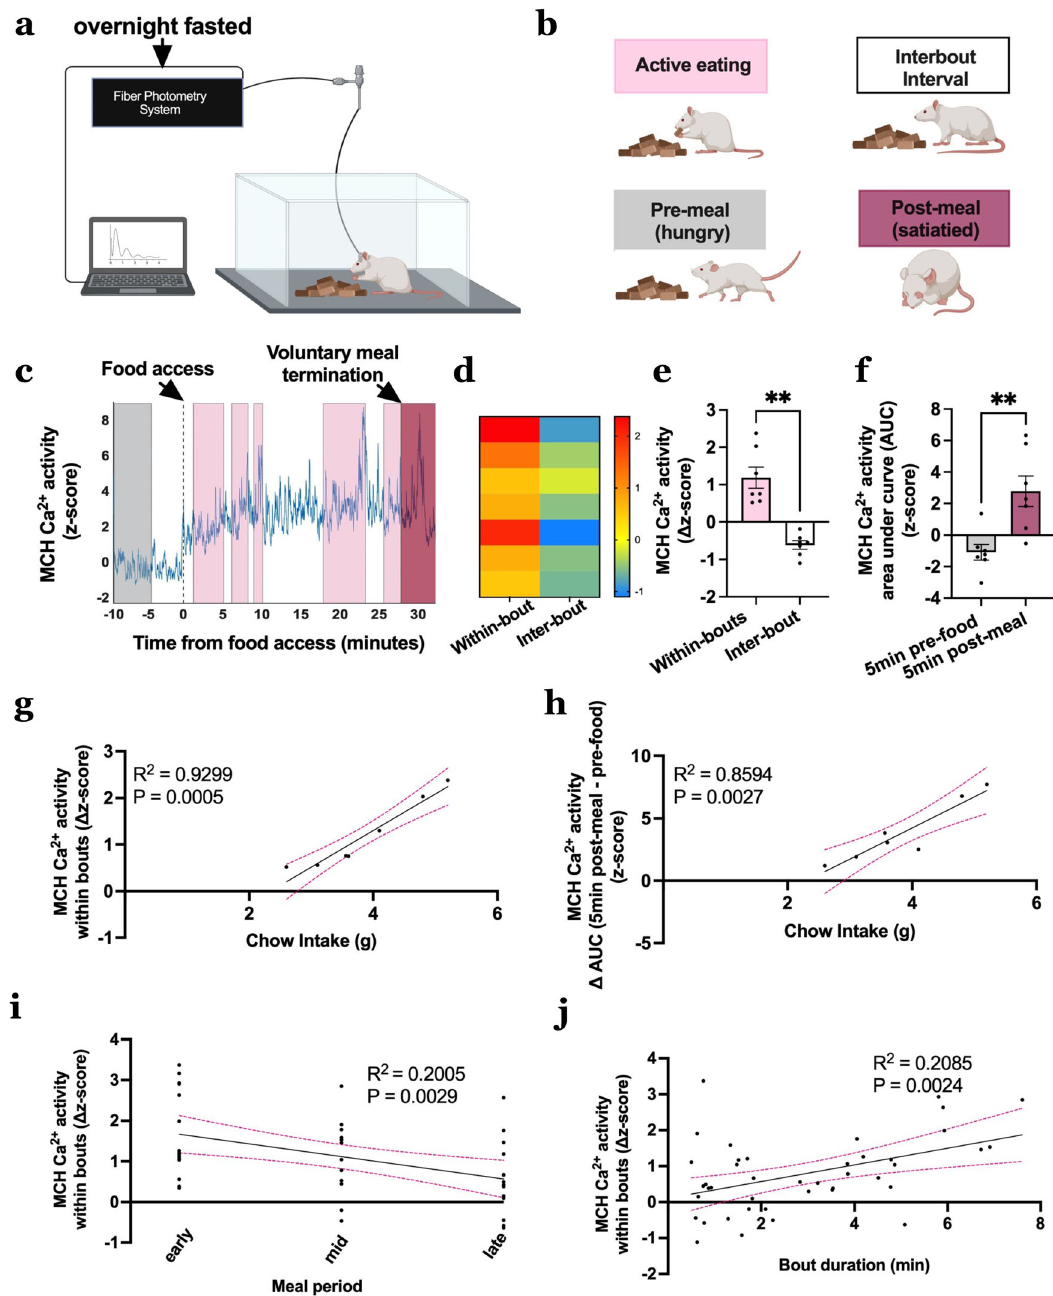
Fig. 3 | Physiological MCH neuron Ca 2+ activity increases during active feeding and is highly predictive ofcumulative caloric intake and eating bout duration withinameal.a Schematicdiagramdepicting fi berphotometryrecordingofMCH neuron Ca 2+ activity during refeeding after an overnight fast in rats ( n =7). b Schematic cartoon depicting different feeding phases ofrefeeding after the fast. c Representative trace of MCH neuron Ca 2+ activity during refeeding after a fast time locked to food access ( − 10 to 30min relative to the start food access [dotted vertical line]). Premeal [gray box], active eating [pink boxes; quanti fi ed as the dif- ferenceinactivitybetweenstartandend ofeating bout],interboutintervals[white boxes;quanti fi edasthedifferenceinactivitybetweenafterendingeatingboutand before starting next eating bout] and voluntary satiation [dark pink box] are represented. d Heatmaprepresentingeachanimal ’ sMCHneuronCa 2+ signalduring activeeatingboutsandinterboutintervals e – j FiberphotometryrecordingofMCH neuron Ca 2+ activity during refeeding after a fast (data analyzed using Student ’ s two-tailed paired t -test, n =7 rats) with e MCH neuron Ca 2+ activity within eating